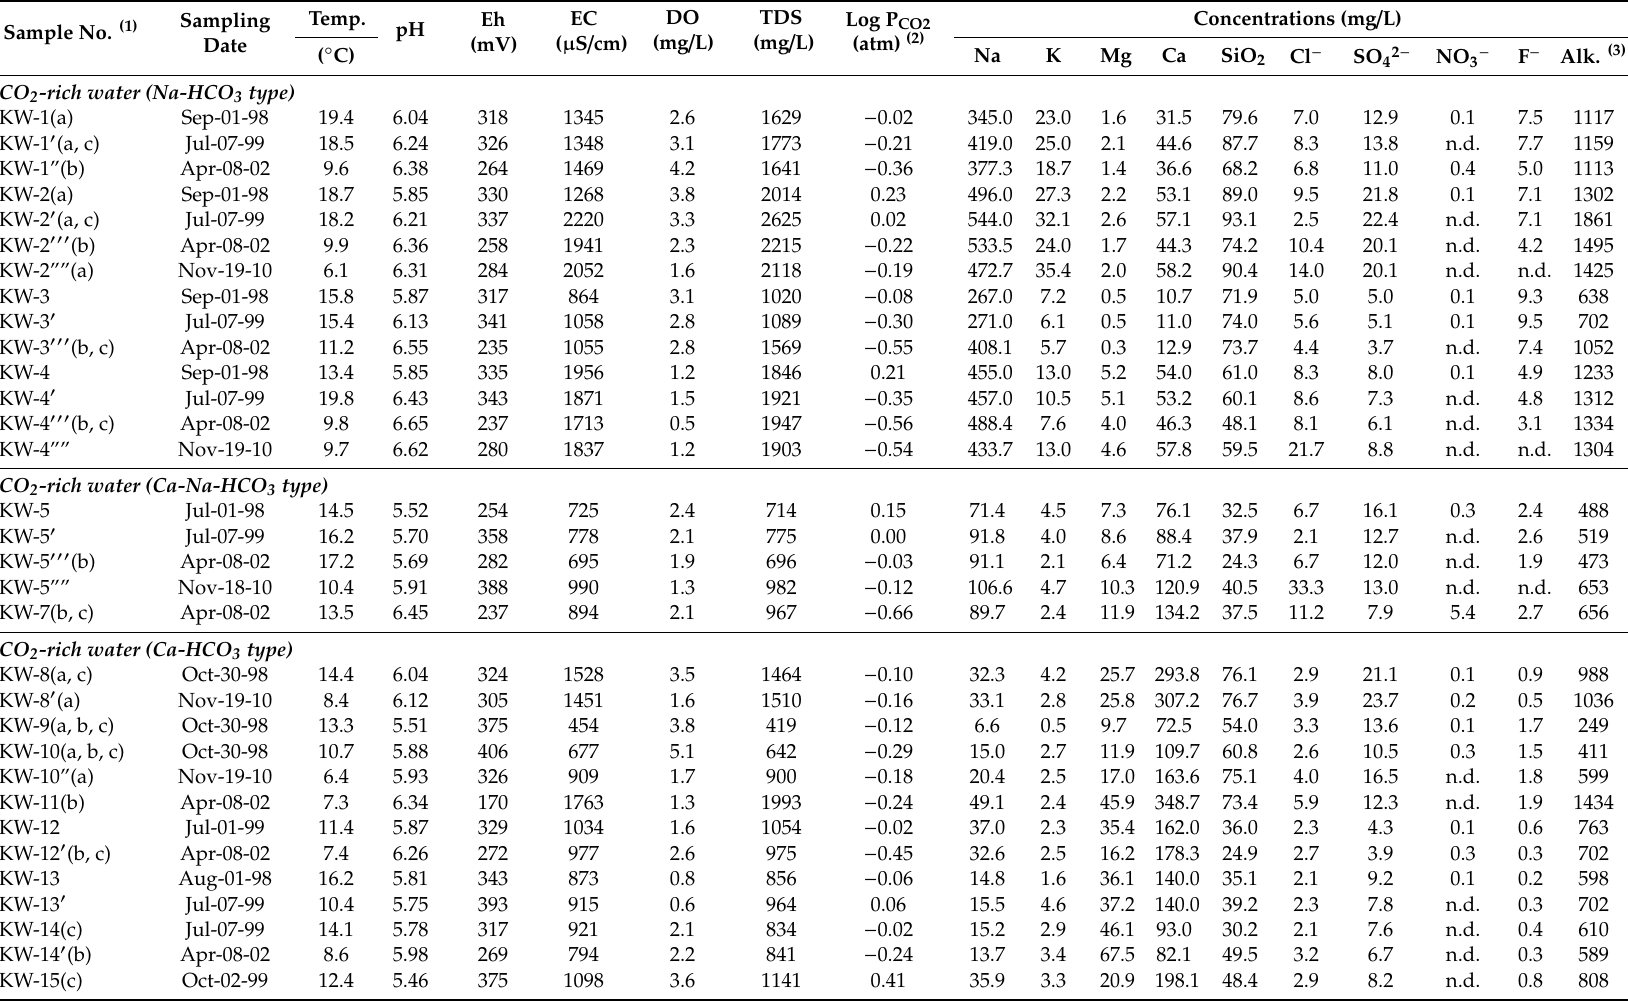
Table 1. Physicochemical data of water samples in the Gangwon Province of South Korea. CO 2 -rich water is grouped based on the Piper diagram (see Figure 3). Sample No.